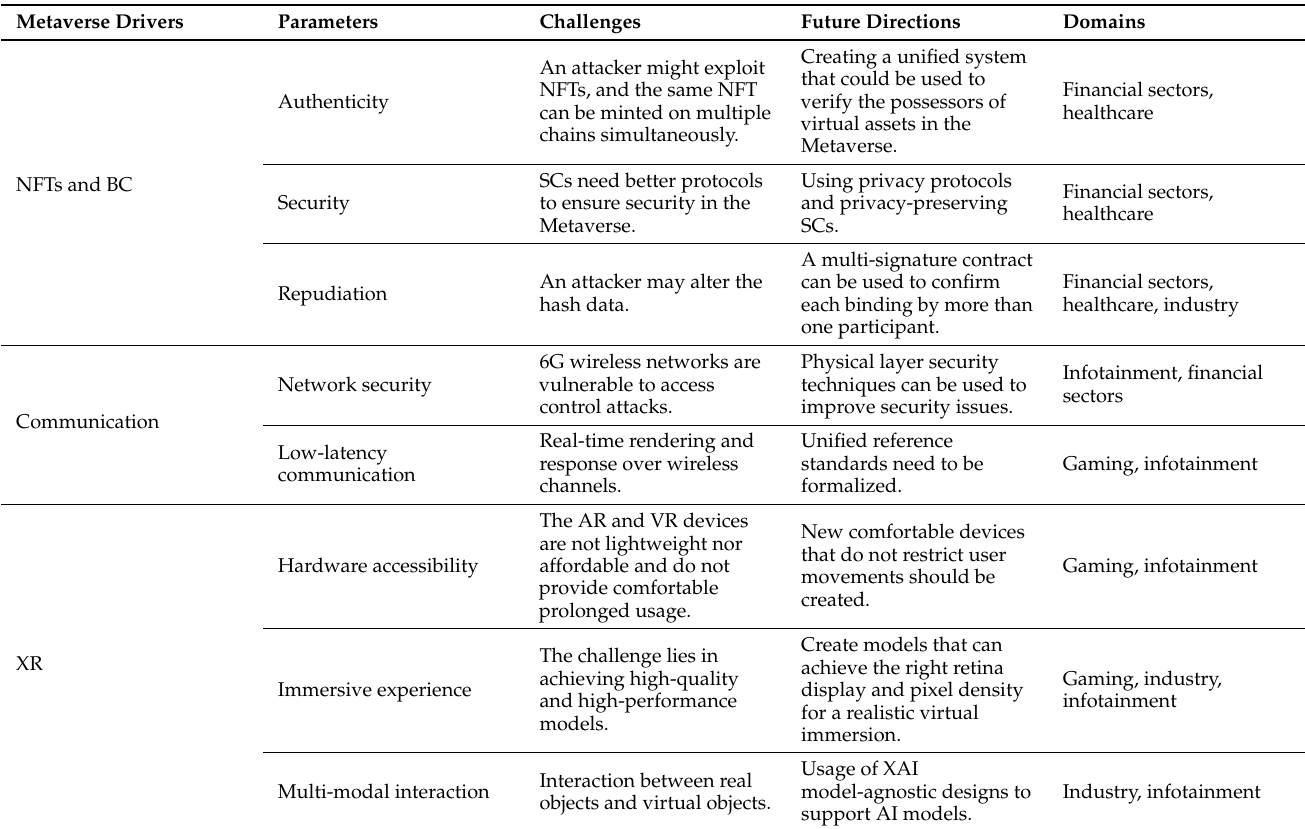
Table 6. Challenges and future directions for Metaverse-assisted key